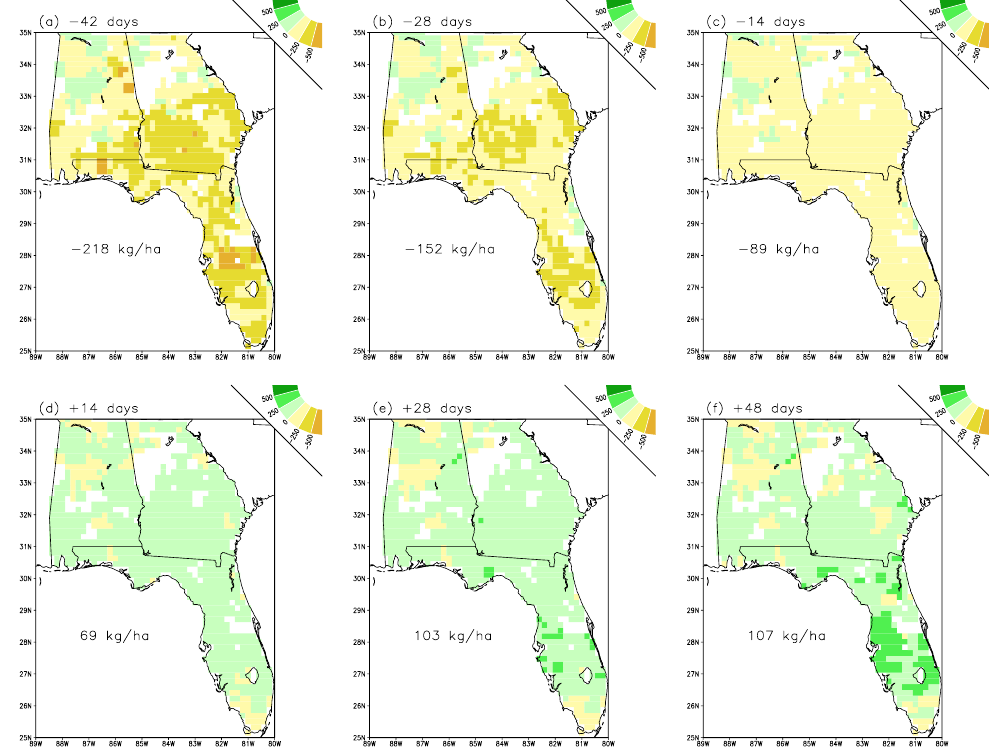
Figure 9. As in Figure 7, but for cotton using the NARCCAP HH model.